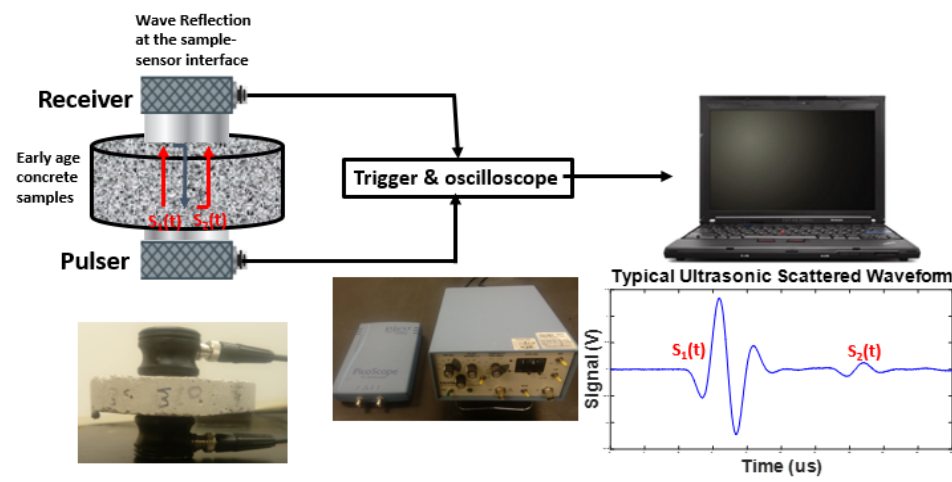
Figure 1. Demonstration of the ultrasonic scattering measurement of air void size distribution in concrete samples.